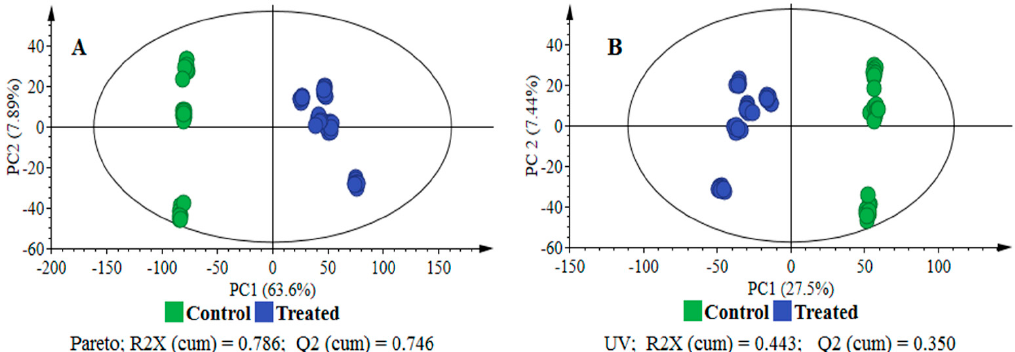
Figure 4. PCA score scatterplots. PCA models of the same data X, but with different scaling methods. ( A ) A five-component model, explaining 78.6% variation in the Pareto-scaled data, X, and the amount of predicted variation by the model, according to cross-validation, is 74.6%; and ( B ) A five-component model, explaining 44.3% variation in the unit variance (UV)-scaled data, X, and the amount of predicted variation by the model, according to cross-validation, is 35.0%. Table 3. Statistics of computed PCA and OPLS-DA models illustrating the effect of scaling and transformation on the dataset matrix for Method 1.